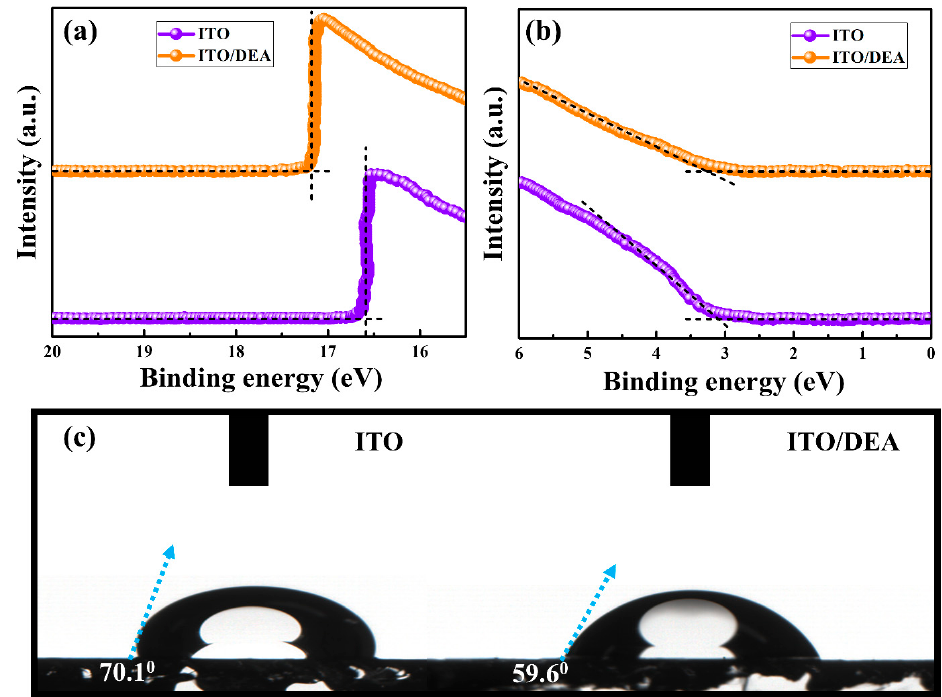
Figure 3. UPS spectra of ITO substrate and ITO/DEA substrate ( a , b ), and the contact angle photographs of water droplets on ITO substrate and ITO/DEA substrate ( c ).